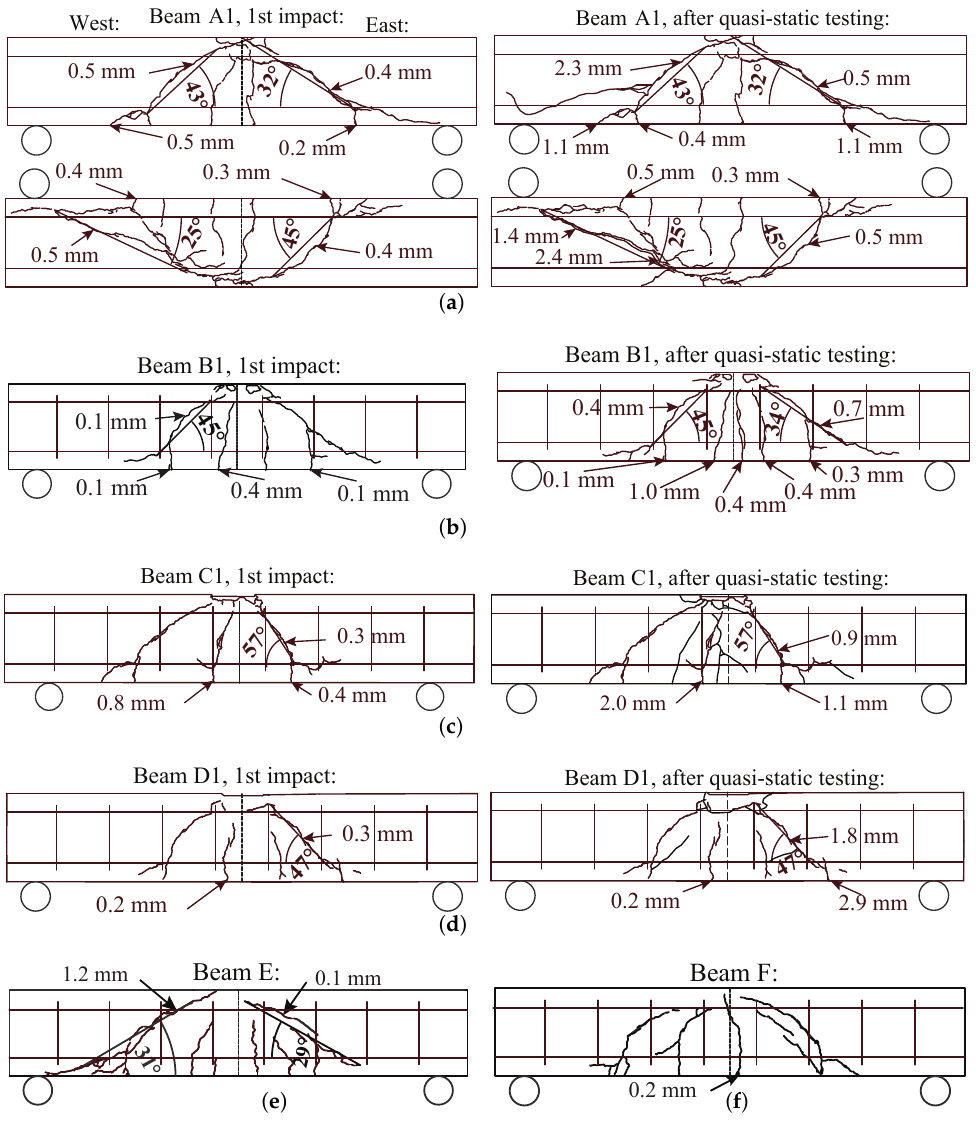
Figure 16. ( a ) Damage to Beam A1 after quasi-static testing; ( b ) damage to Beam B1; ( c ) damage to Beam C1; ( d ) damage to Beam D1; ( e ) damage to Beam E; and ( f ) damage to Beam